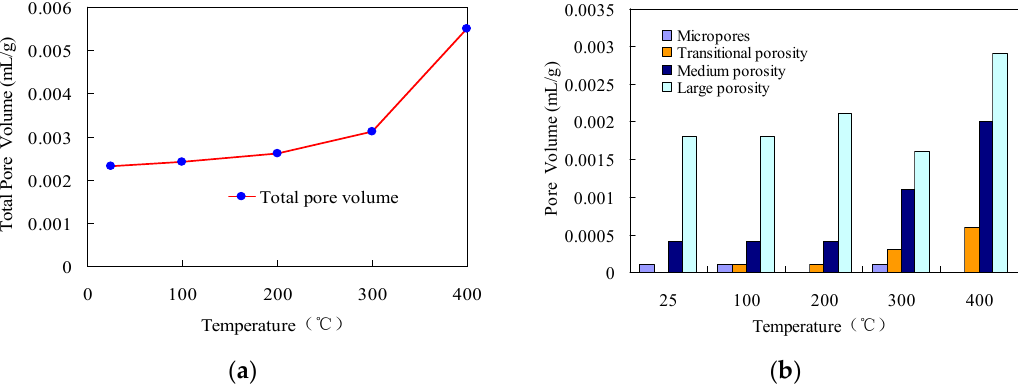
Figure 9. Pore volume of granite at different temperatures: ( a ) total pore volume, ( b ) pore volume of various pores. According to Table 3 and Figure 9a, from 25 ◦ C to 400 ◦ C, the total pore volume